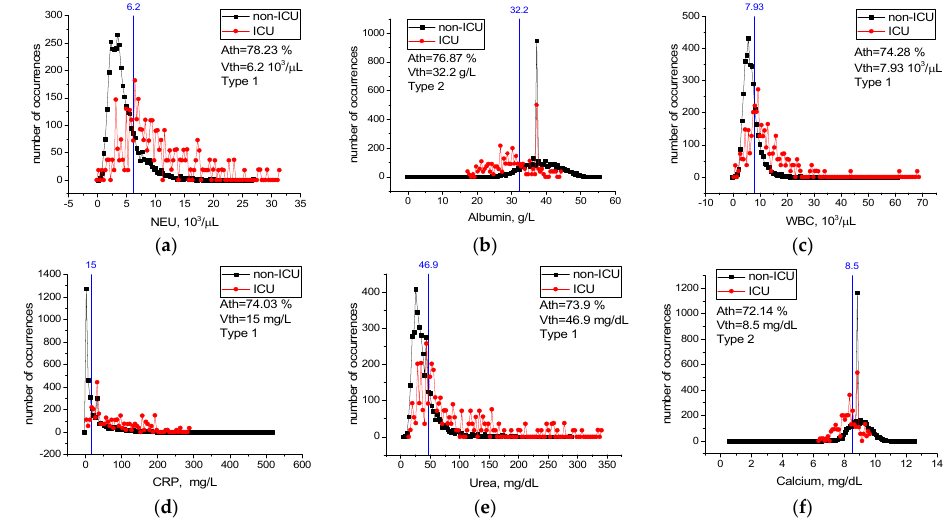
Figure 9. Case distribution histograms for NEU ( a ), Albumin ( b ), WBC ( c ), CRP ( d ), Urea ( e ), Calcium ( f ) from mildly and severely infected COVID-19 patients and the threshold values Vth of these features (blue line) in the prognosis of the disease. Histogram bin sizes are listed in Table